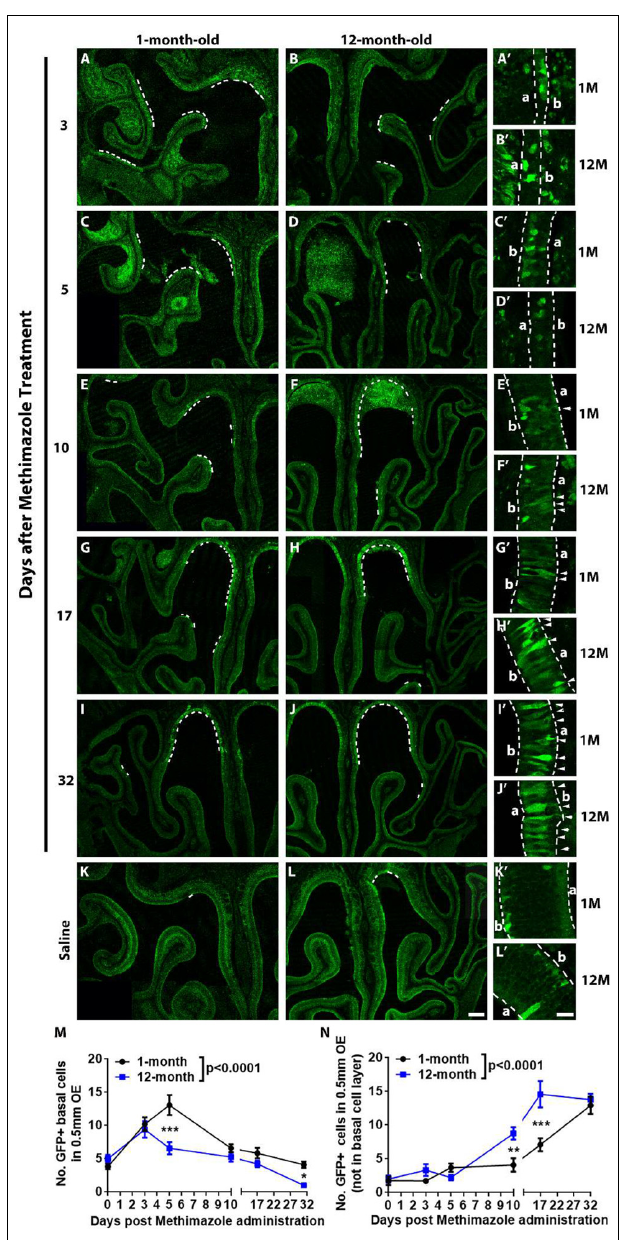
FIGURE 3 | Aging led to the attenuation in recruitment of Lgr5+ cells in injured OE. Confocal images of Lgr5-EGFP+ cells in the OE of 1- and 12-month-old Lgr5-EGFP-CreERT2 mice at Day 3 (A,B) , Day 5 (C,D) , Day 10 (E,F) , Day 17 (G,H) , and Day 32 (I,J) postinjury as well as in the OE of uninjured saline control (K,L) . Positive staining against GFP was labeled by dash lines in (A–L) . Panels (A’–L’) were magnified regions in (A–L) . Lgr5-EGFP+ cells in the nonbasal layers were labeled by arrowheads. Dash lines in (A’–L’) represented boundary of the OE. (M,N) Statistical analysis of Lgr5-EGFP+ cell density in basal and nonbasal cell layers of injured OE from young and aged mice. At Days 3, 5, 10, 17, and 32 postinjury, 207, 798, 549, 336, 333, and 222 Lgr5-EGFP+ basal cells were counted in saline controls and in 1-month-old mice. In 12-month-old mice, 150, 480, 237, 348, 279, and 51 Lgr5-EGFP+ basal cells were counted. In 1- and 12-month-old mice, 111, 141, 144, 258, 447, 738 Lgr5-EGFP+ nonbasal cells and 66, 180, 87,